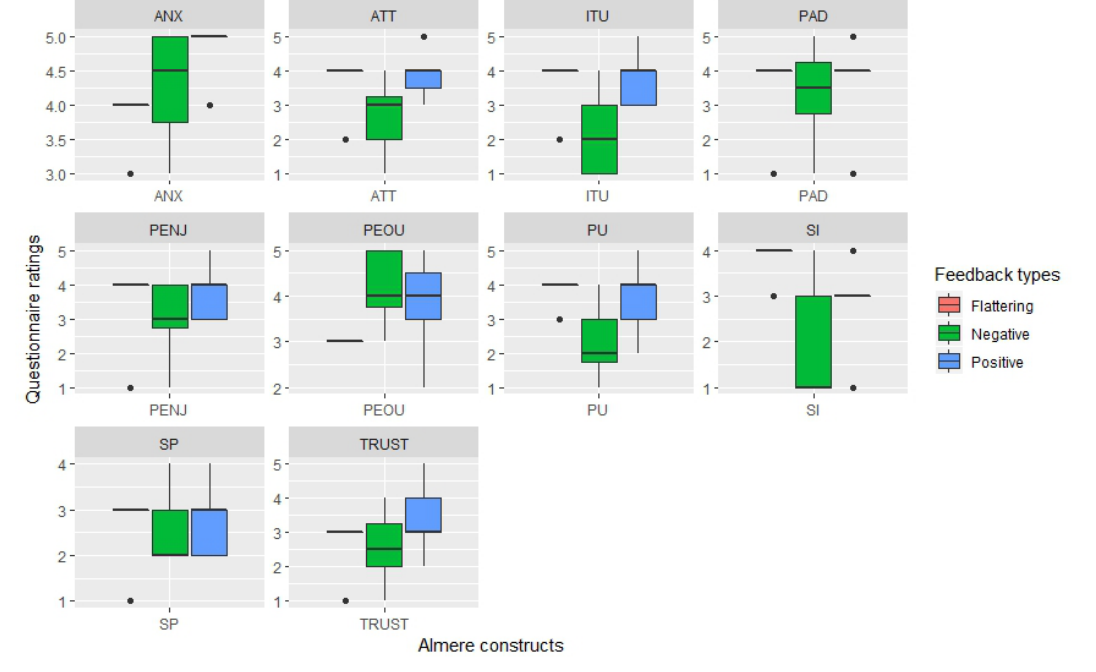
Figure 4. Box plots of Almere